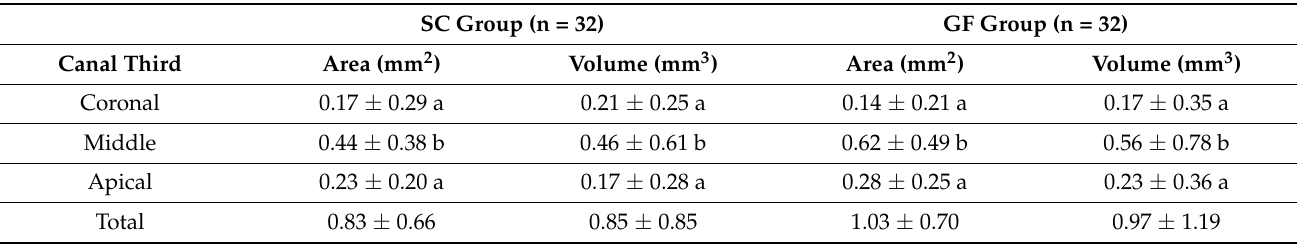
Table 3. Area (mm 2 ) of root canal remnants calculated on radiography and the Volume (mm 3 ) calculated by the use of CBCT and visible into the root canal after the secondary treatments with RB #25 and with RB #40. Area and Volume were measured at coronal, middle and apical thirds. Mean ± Standard Deviations.